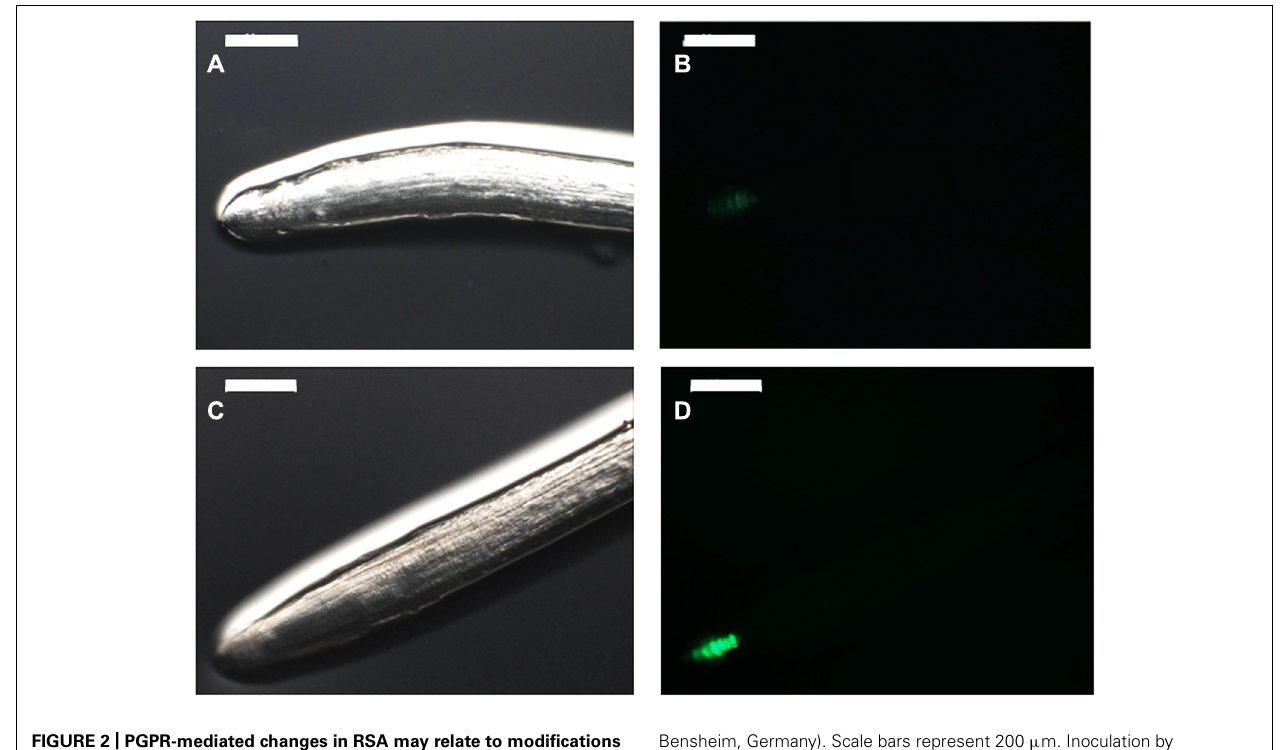
FIGURE 2 | PGPR-mediated changes in RSA may relate to modifications of auxin content in roots . Six-day-old Arabidopsis plantlets expressing the GFP gene under the control of the auxin-sensitive DR5 artificial promoter were inoculated (C, D) or not (A, B) with the PGPR Phyllobacterium brassicacearum STM196. Six days later, root tips were observed under normal light (A, C) or UV light (B, D) with a microscope (Z16APO, Leica,